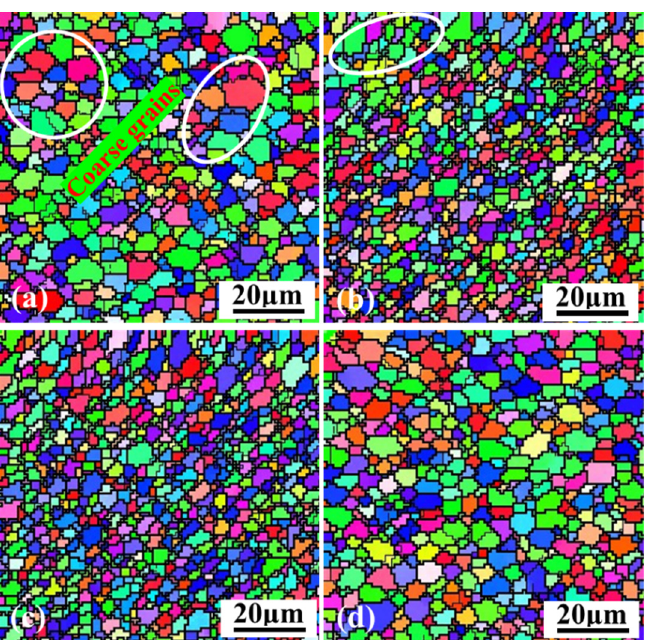
Figure 3. Grain size in the NZ: ( a ) 90 mm/min; ( b ) 120 mm/min; ( c ) 150 mm/min; ( d ) 180 mm/min.